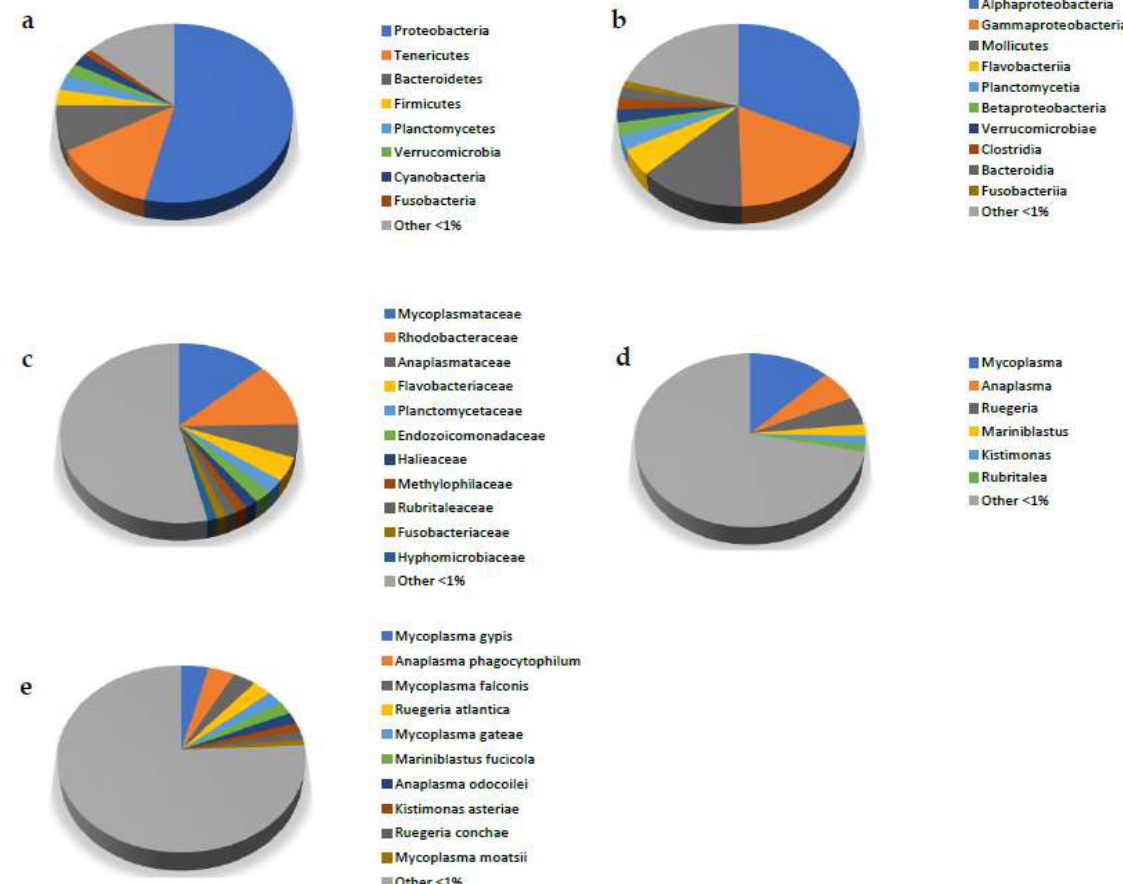
Figure 2. The whole M. galloprovincialis microbiome at the ( a ) phylum, ( b ) class, ( c ) family, ( d ) genus and ( e ) species levels. Pie charts were obtained using only the classified reads of the 15 samples. Only bacteria with relative abundance ≥ 1% were included.